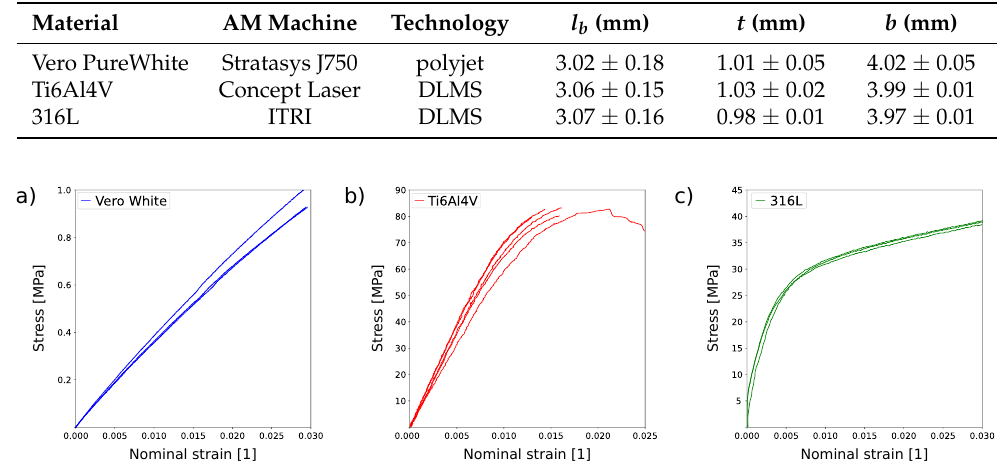
Figure 4. Stress–strain curves for regular honeycomb structure additively manufactured from ( a ) Stratasys Vero White polymer, ( b ) titanium alloy Ti6Al4V, and ( c ) stainless steel 316L. Curves were obtained in tensile tests.